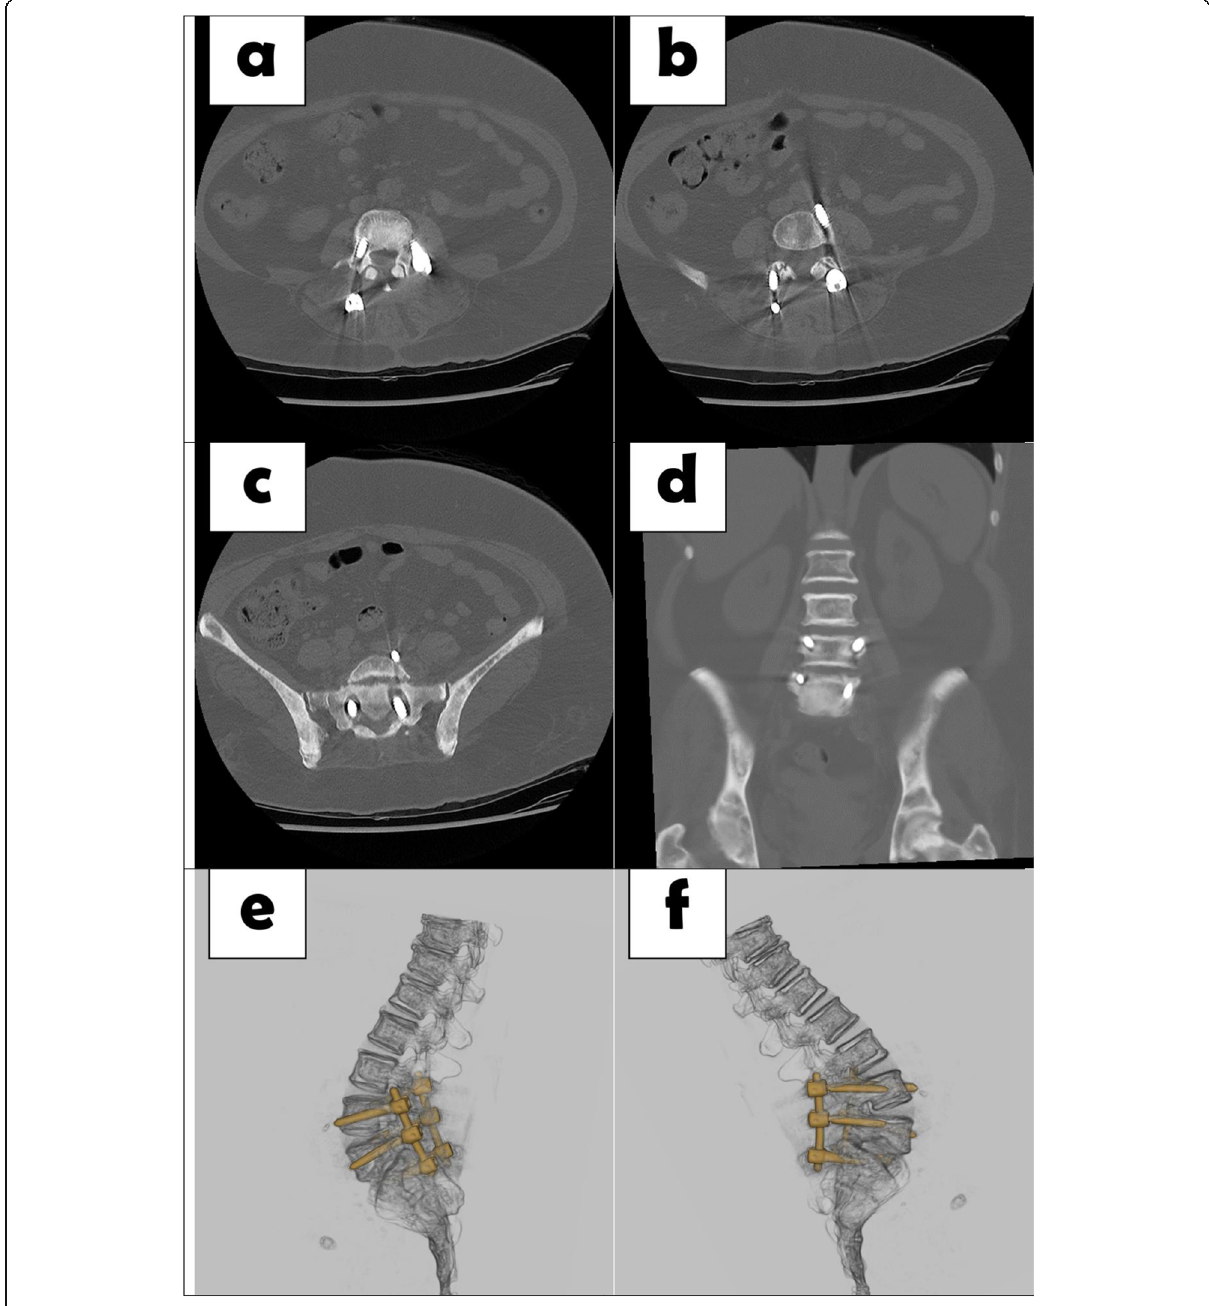
Fig. 3 Internal fixation of L4, L5, and S1 vertebrae with rods and multiple screws. a – c Axial cuts are showing lateral violation of the screw in the left pedicle of L4 vertebra (grade III) and anterior vertebral body penetration of L4, L5, and S1 vertebrae by the right and left screws, and there is widening of the furrow “ tunnel ” around the screws. d Coronal reconstruction is showing penetration of the upper vertebral end plate of L4 vertebra by the screws. e , f 3D reconstruction sagittal cuts confirm the anterior penetration of the anterior aspects of the